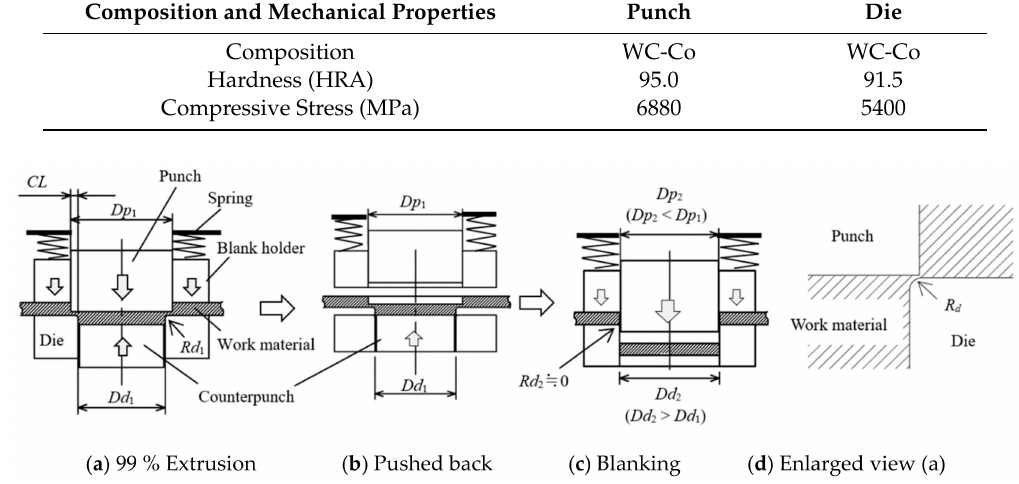
Figure 1. Schematic of extrusion blanking used in the mass-production progressive die system [11]. Table 3. Blanking tool